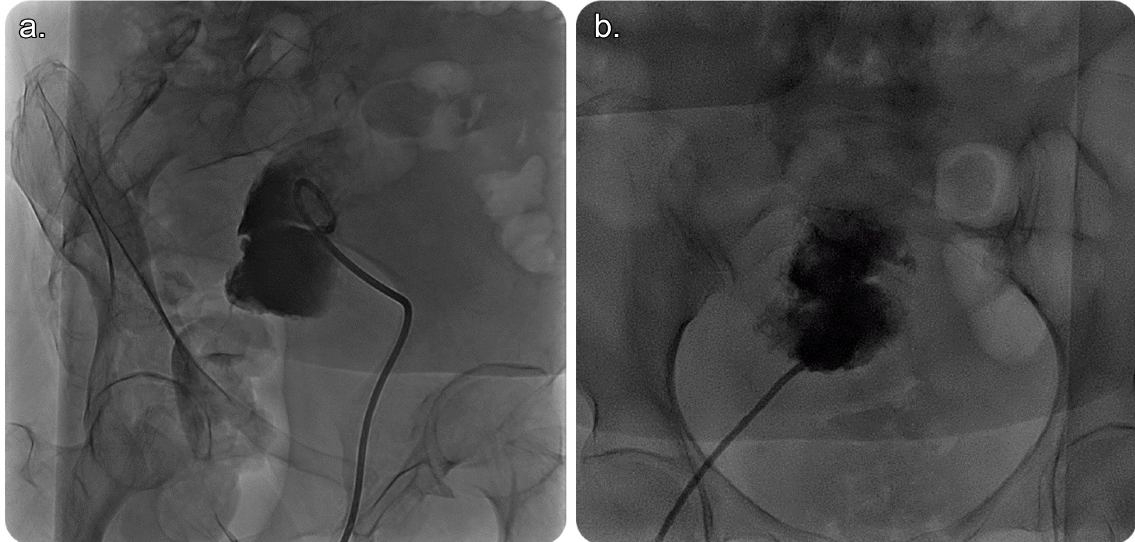
Figure 3. ( a ) Fluoroscopic image of the pelvis in an oblique view showing a 10-French-size pigtail catheter within the endometrial cavity that is filled with contrast material, with no evidence of contrast passage beyond the stenosed/obstructed cervix into the vagina outside the body. ( b ) Fluoroscopic image (frontal view) showing a 10-French-size pigtail catheter within the endometrial cavity that is filled with contrast with a clear cut-off, which indicates obstruction.